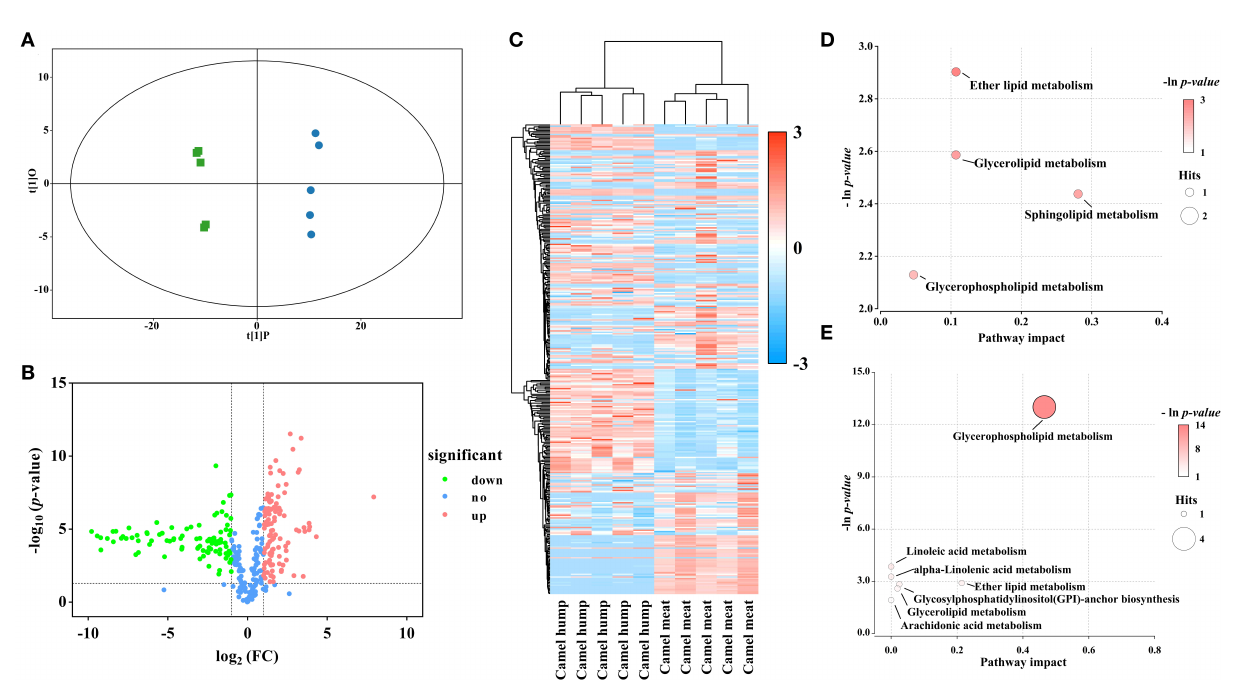
FIGURE3 Statistical analyses of lipids in camel hump vs. camel meat. (A) OPLS-DA scores plot. Green squares represent camel hump, blue circles represent camel meat (R 2 Y = 0.996, Q 2 = 0.991). (B) Volcano plot using log 2 FC as the x-axis, -log 10 ( p < 0.05) as the y-axis, FC values were the ratios of lipid content in camel hump to that in camel meat. (C) Heat map analysis and hierarchical clustering of differential abundance lipids between camel hump and camel meat. To build the heat map, normalized abundances were used; the red color represents high abundance, whereas the blue color represents low abundance. Bubble plots of KEGG pathway analysis in positive (D) and negative (E) ionization mode, and the supplementary data showed in Supplementary material